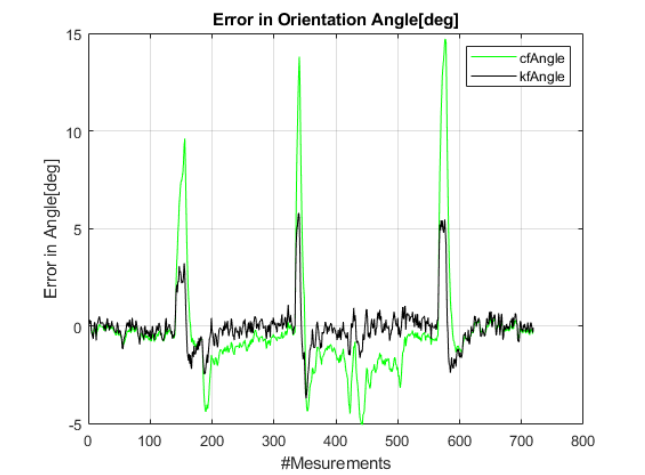
Figure 21. Error in the integrated angle of the Mantis v2